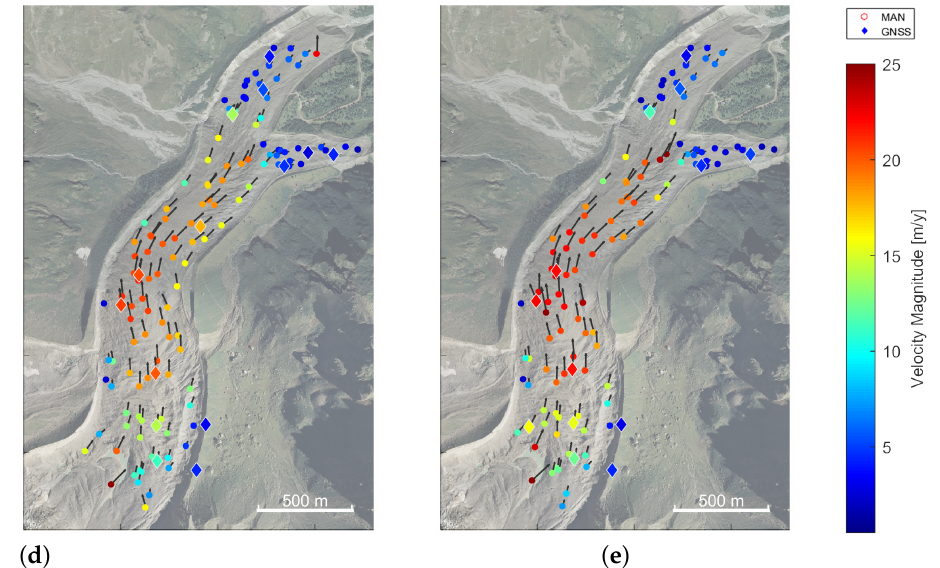
Figure 7. Measured GNSS and MAN velocities for each year: ( a ) 2015–2016, ( b ) 2016–2017, ( c ) 2017–2018, ( d ) 2018–2019, ( e ) 2019–2020. Dots represent MAN measurements, diamonds re- fer to GNSS measurements. Note that the velocity field for 2017–2018 were derived from the surveys of October 2017 and July 2018, and therefore velocities refer mostly to the wintertime and thus they are smaller than the annual ones.